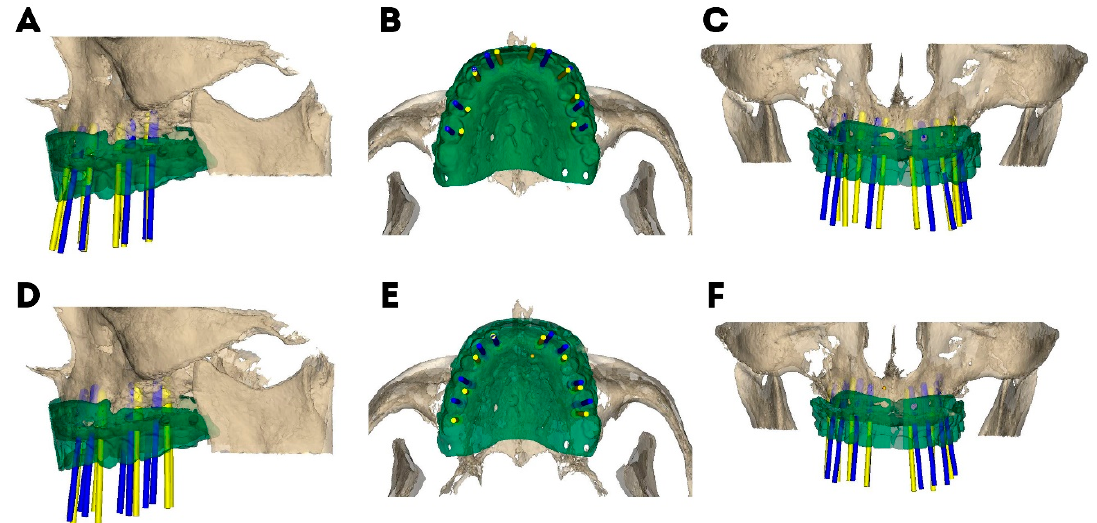
Figure 2. Dental implant planning before (yellow cylinders) and after (blue cylinders) using the digital mock-up in both study groups (5–10 years’ experience ( A – C ) and no experience ( D – F )).